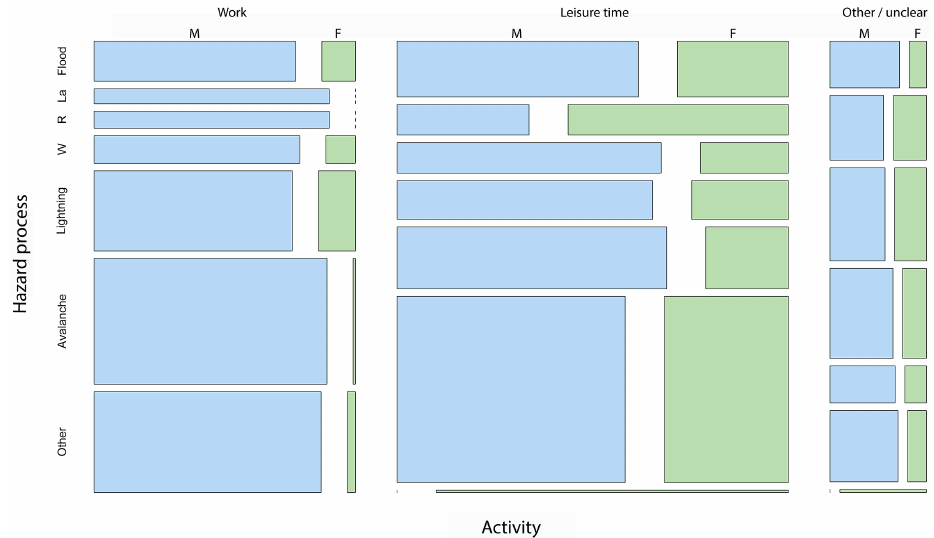
Figure 12. Mosaic plot showing the activity and gender of victims (M is male, F is female) for natural hazard fatalities in Switzerland (1946– 2015). Fatalities are subdivided according to the hazard category (flood, La is landslide, R is rockfall, W is windstorm, lightning, avalanche and other). Also see Table 2. Table 2. Natural hazard fatalities in Switzerland (1946–2015) classified by activity, accident locality and mode of